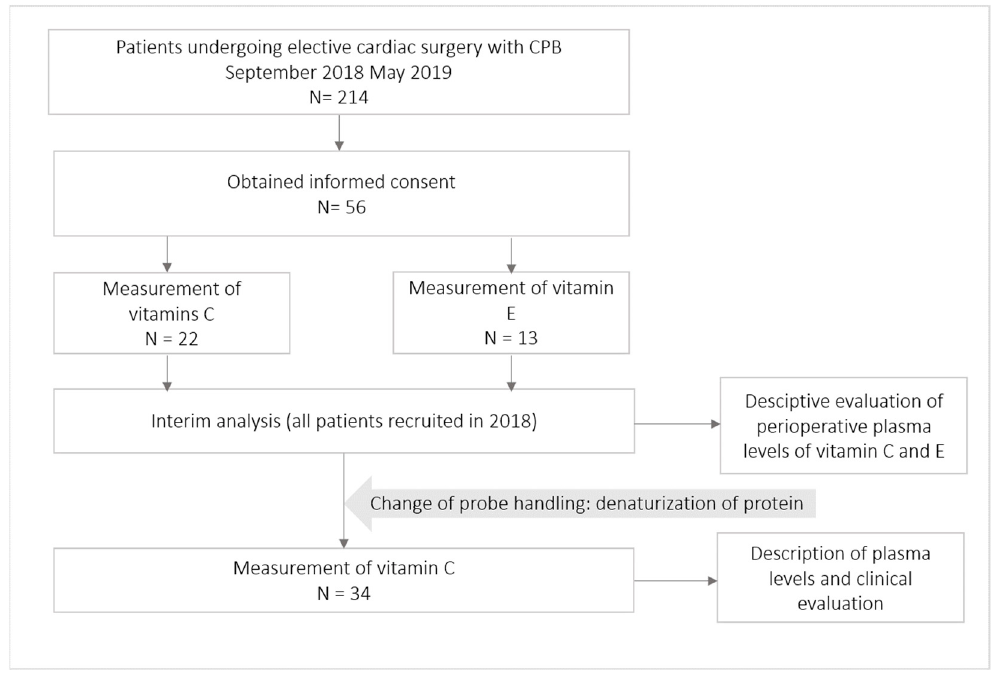
Figure 1. Patient flowchart. N, number of patients.